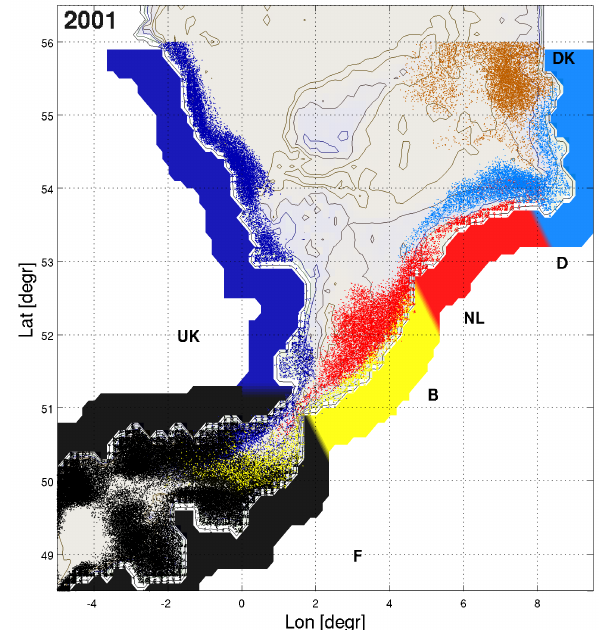
Figure 6. Distribution of the origin of particles that settle (shown in blue dots). Please note that all 1000000 particles are included in this figure. On top of that, different pie charts show the geo- graphic variation of the different outcomes of particle development and drift: (blue) particles that settle; (grey) particles that do not set- tle; (orange) particles that do not settle but also do not reach end of the 3-day settlement stage before the numerical simulation is trun- cated after 120 days; (red) particles that do not settle as these have not yet reached the beginning of their 30-day settlement stage, be- fore simulation is truncated. The red segment of the pie charts indi- cates particles that are still in their larval stage after 120 days.